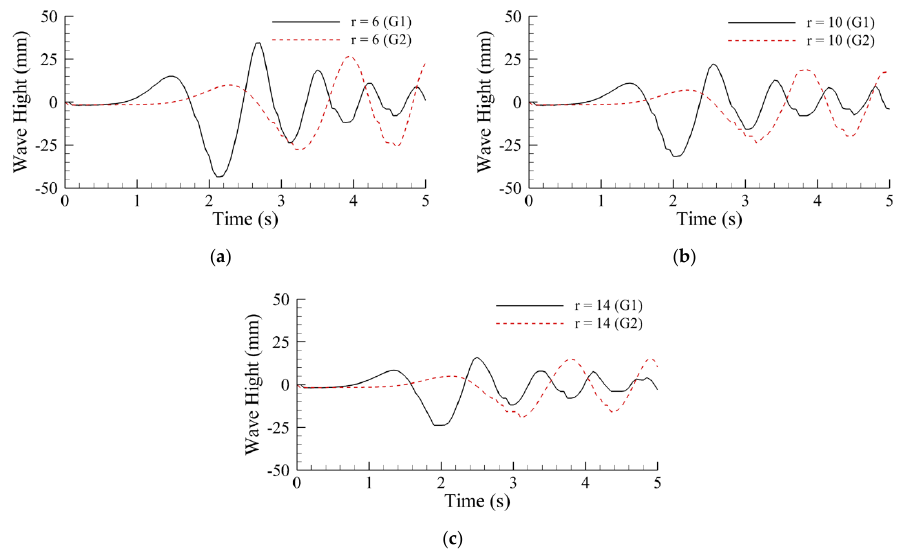
Figure 18. The temporal evolution of the water elevation in G 1 and G 2 with the submarine landslide: ( a ) r = 6; ( b ) r = 10; and ( c ) r = 14.